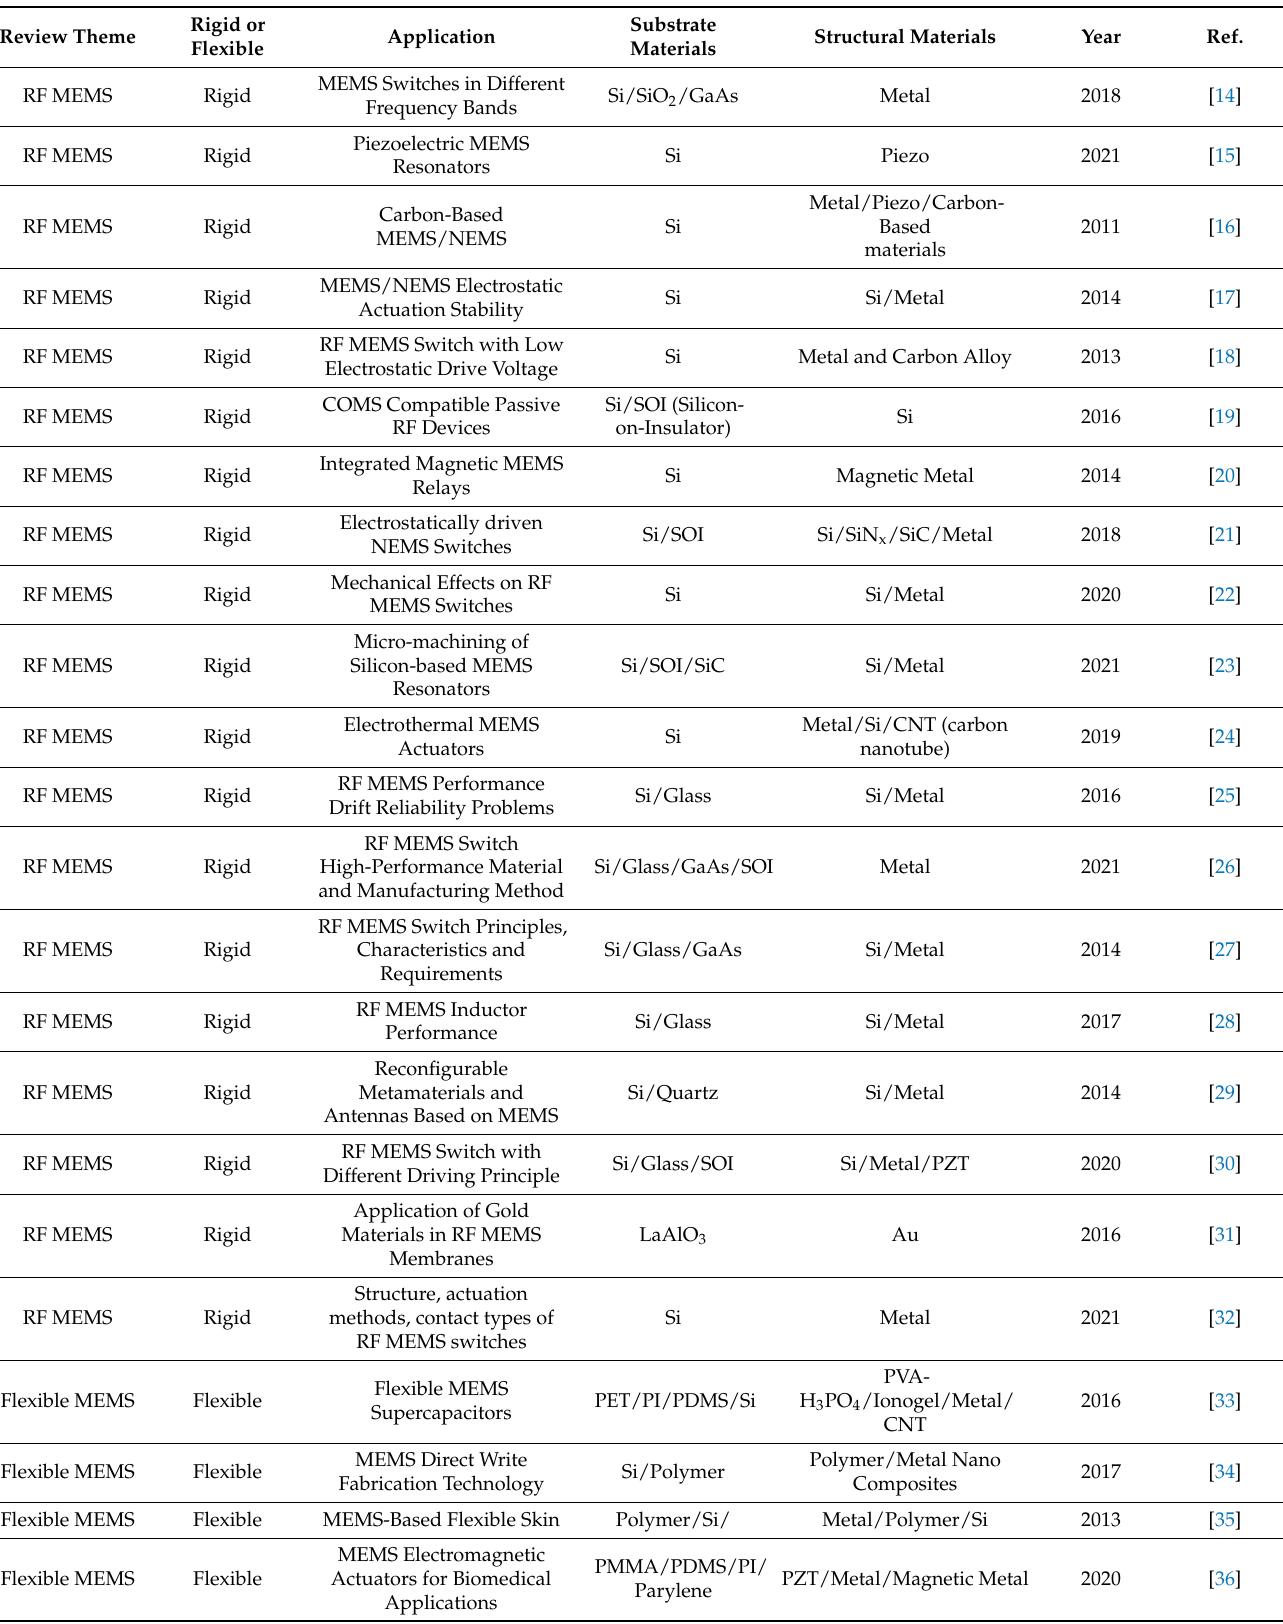
Table 1. Comparison of RF MEMS/Flexible MEMS